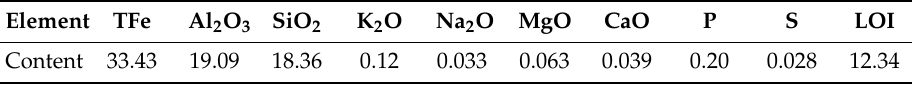
Table 1. Chemical compositions of high aluminum iron ore (HAIO) (wt.